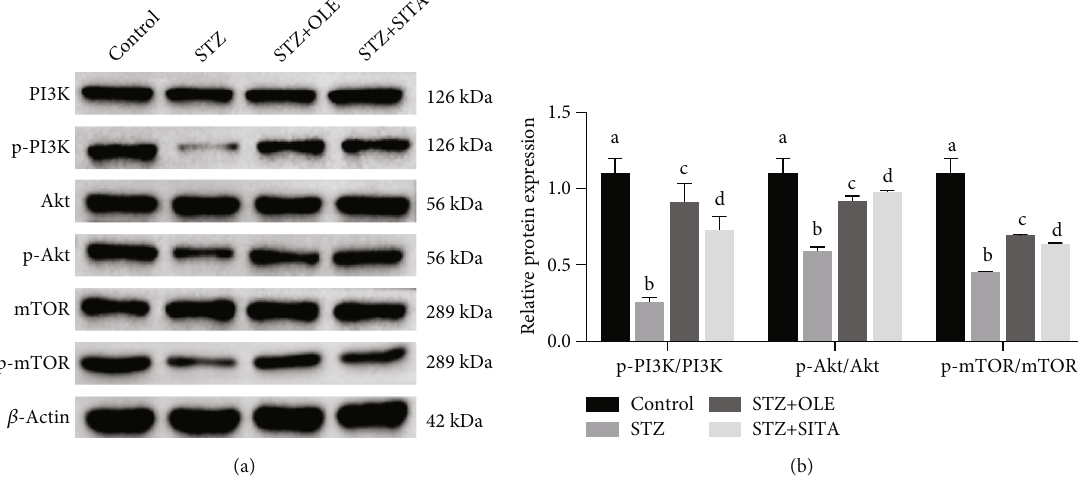
Figure 5: The e ff ect of oleuropein on the PI3K/Akt/mTOR signaling pathway in hippocampus tissue of diabetic rats. Western blot original images (a) and quantitative gray-scale analysis (b) of PI3K/Akt/mTOR signaling pathway-related proteins in the hippocampus tissues of rats. Each set contains data from 3 samples tested independently; LSD test was used for multiple comparisons. ∗∗ p < 0 : 05 vs. control group and ## p < 0 : 05 vs. STZ